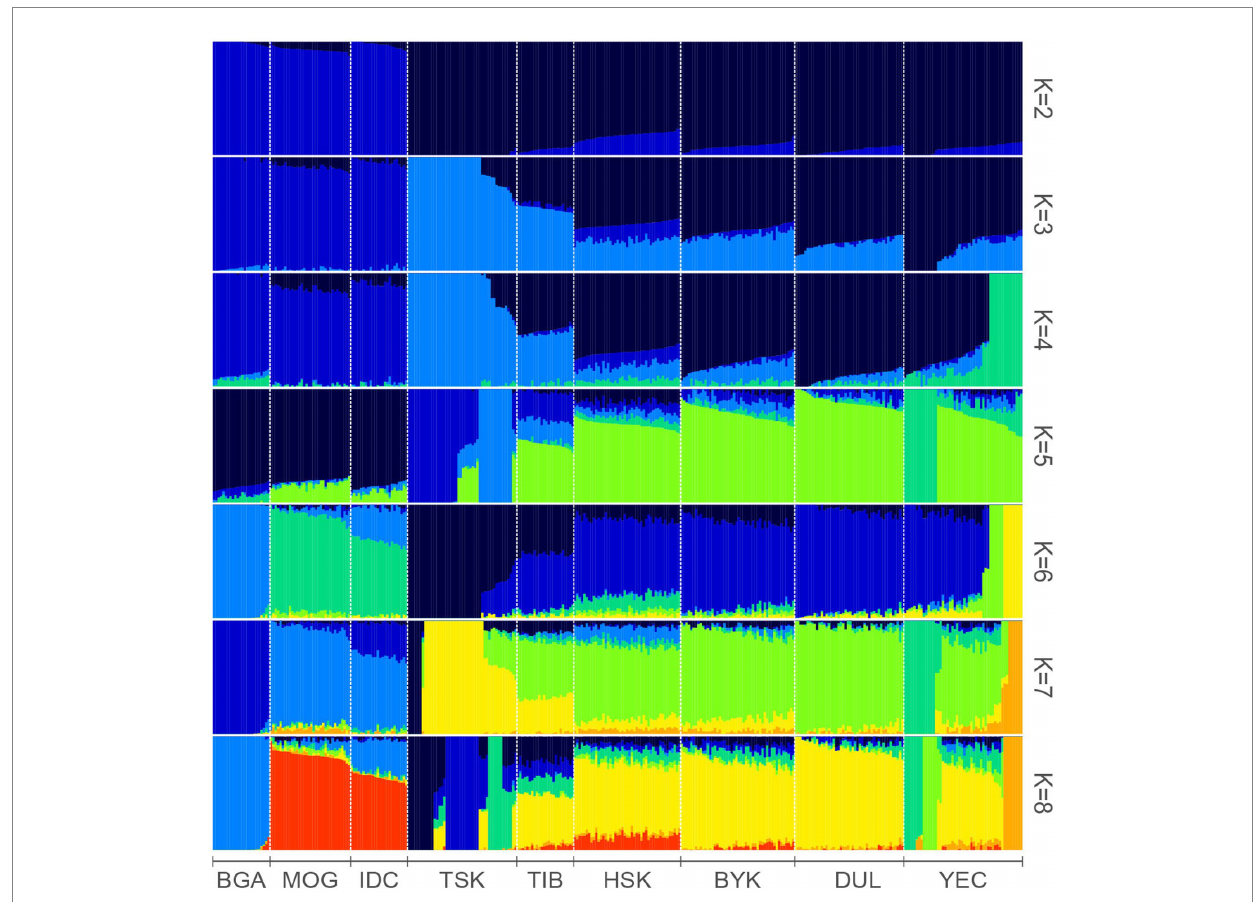
FIGURE 2 Admixture analysis of nine sheep breeds. Results for inferred numbers of clusters k = 2–8 were shown. Different colors represent different ancestral